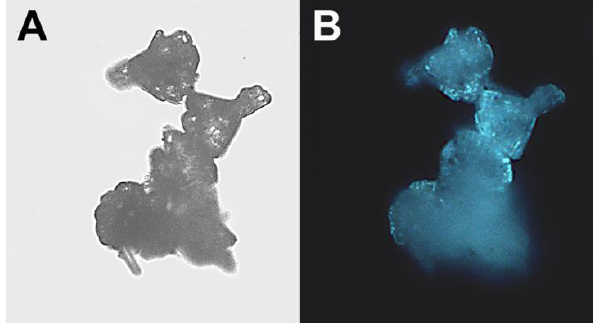
Figure 5. “Cauliflower-like” ZnO microparticles: ( A ) Light and fluorescent; ( B ) microscope images. (Original magnification: ×400).